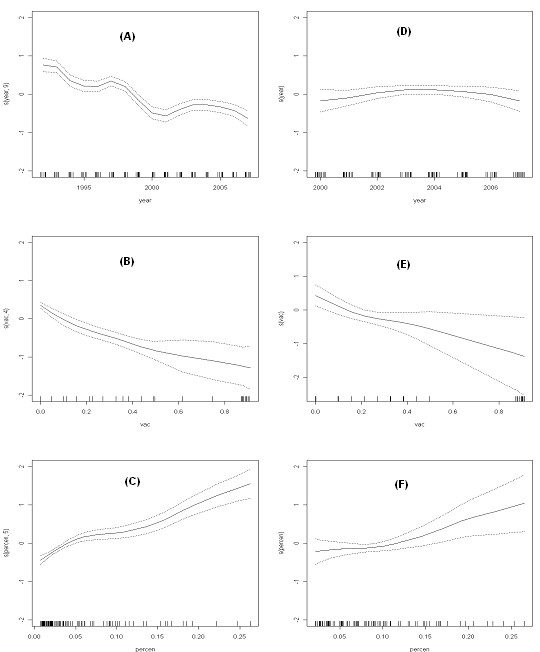
The number of cases of hepatitis B have been modelled as smooth functions of year of report (year), vaccination coverage (vac) and proportion of immigrants (percen), using a GAM model. Results for the gam1 model (period 1992-2007) are on the left panel and on the right panel, those for gam* model (period 2000-2007). The x axis of each plot is labelled with the covariate name and the y axis is labelled s(cov,edf) where cov is the covariate name, and edf the degrees of freedom of the smooth function. Upper and lower pointwise twice-standard-error curves are included (dashed lines).